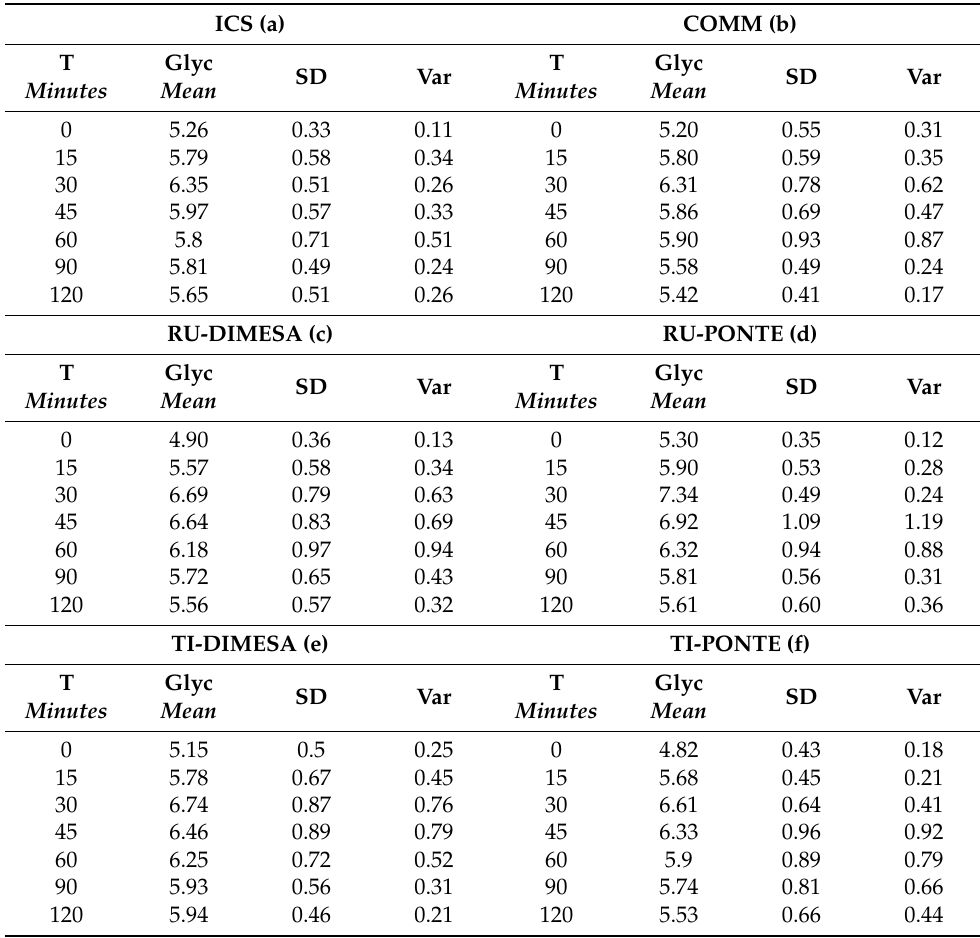
Table 6. For pasta sample ICS, COMM, RU-DIMESA RU-PONTE, TI-DIMESA, TI-PONTE